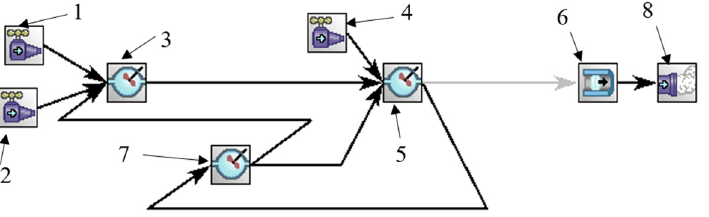
Figure 3. Reactor diagram for burning in HOSS as per Ansys Chemkin-Pro; 1—oxidizer entry (mixture of oxygen and steam); 2—hydrogen entry; 3—mixing zone for oxidizer and fuel; 4—entry for supply of water vapor; 5—burning zone; 6—outlet collector (afterburn stage); 7—combustion discharge recirculation zone; and 8—outlet section.